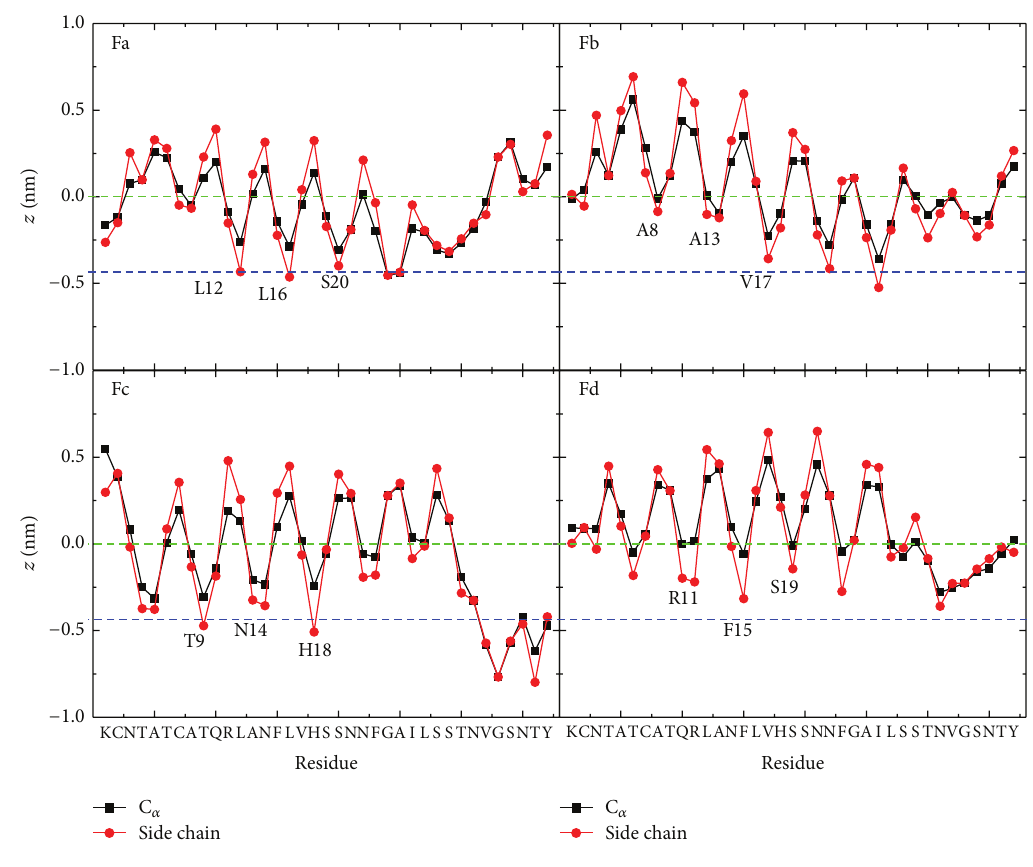
Figure 4: The 𝑧 -positions of the C 𝛼 atom (black) and the side chain centroid (red) of each amino acid residue of hIAPP at POPC bilayer surface. For each membrane binding orientation (Fa, Fb, Fc, and Fd), the 𝑧 -position is averaged using the last 20ns data of each MD run (see Table 1). The green and blue dashed lines correspond, respectively, to the average position of phosphorus atoms and that of carbon atoms of the ester group of lipids, between which is the headgroup region of the upper leaflet. The residues that have a smaller 𝑧 -position relative to their adjacent residues in the helical 8–20 region are labeled in the figure.